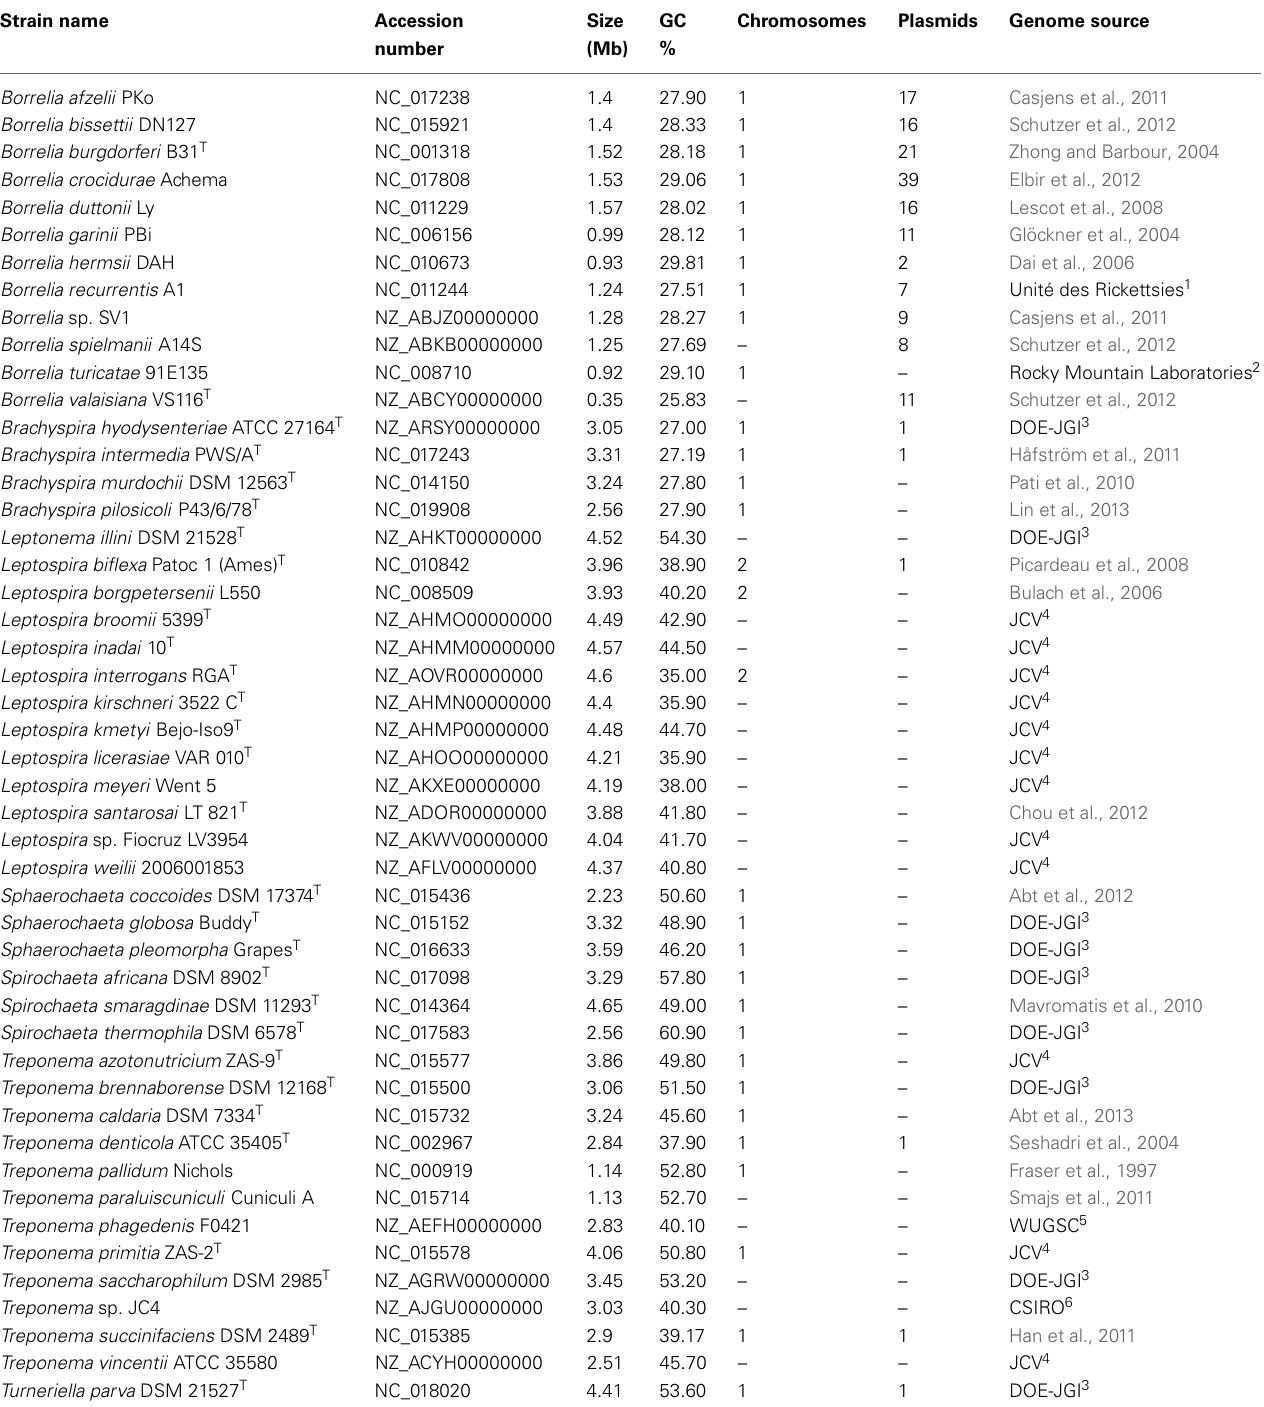
Table 1 | Genome characteristics of the sequenced members of the phylum